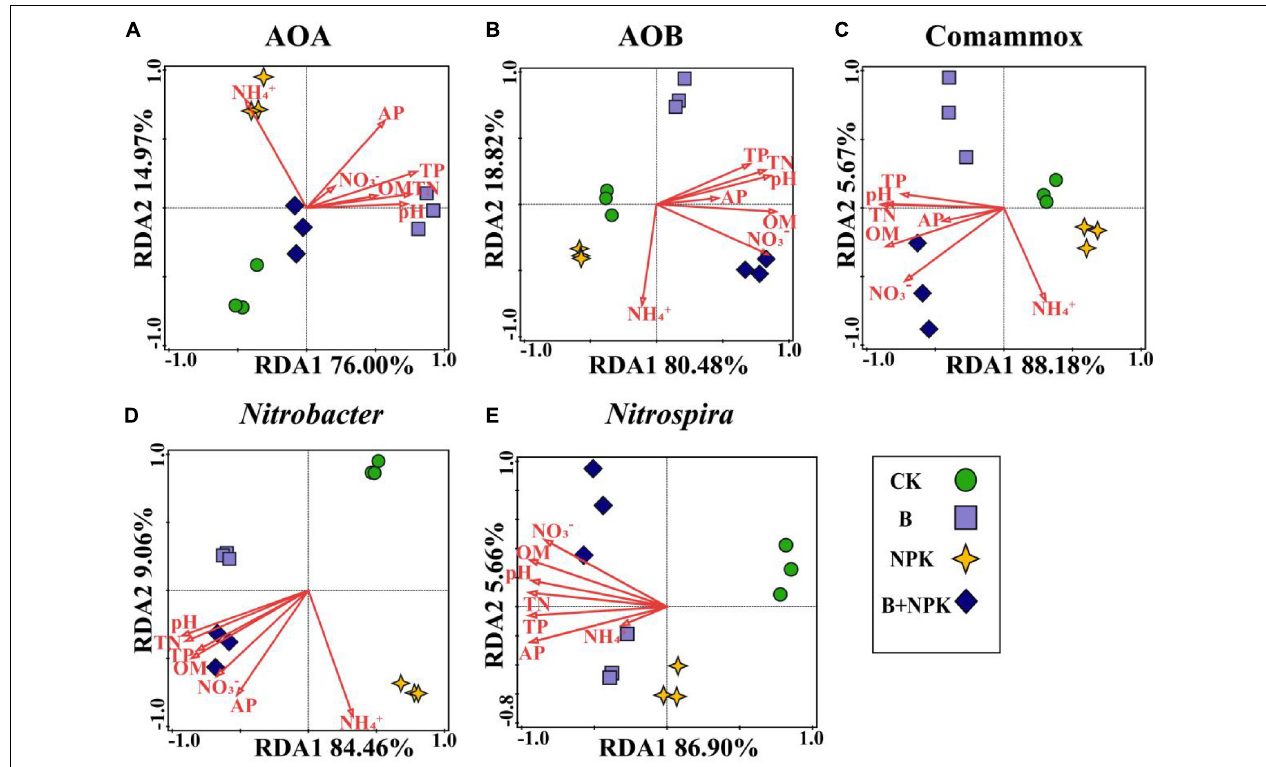
FIGURE 4 | Redundancy analysis (RDA) evaluates the relationships between soil chemical properties and nitrifying communities in rhizosphere soil. (A) Ammonia-oxidizing archaea (AOA), (B) ammonia-oxidizing bacteria (AOB), (C) Comammox Nitrospira , (D) Nitrobacter -like NOB, and (E) Nitrospira -like NOB. Treatments: CK, no fertilizer; B, biochar; NPK, nitrogen, phosphate, and potassium fertilizers; B + NPK, biochar + NPK. OM, soil organic matter; AP, available P; TP, total P, TN: total N; NO 3 − , nitrate-N; NH 4 + ,